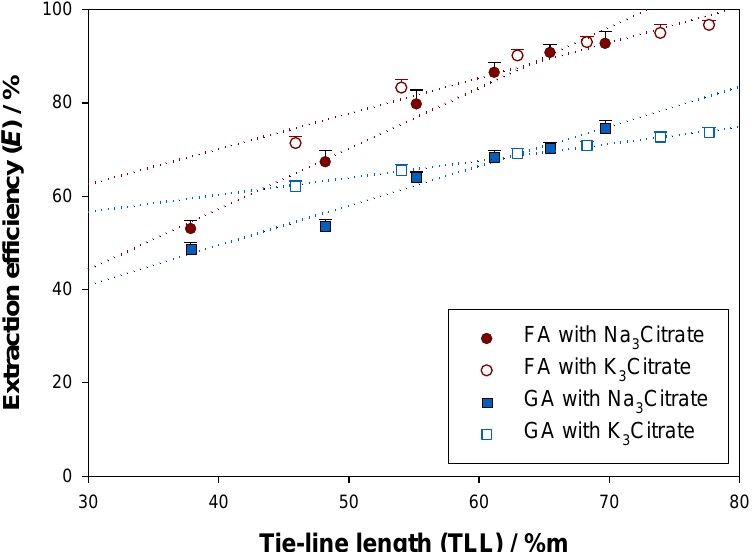
Figure 5. Relation between the extraction efficiencies ( E ) and the tie-line lengths (TLL) for gallic acid (GA) and ferulic acid (FA) in the ATPS {ethyl lactate (1) + trisodium citrate (2) + water (3)} and {ethyl lactate (1) + tripotassium citrate (2) + water (3)} at 298.15 K and 0.1 MPa.